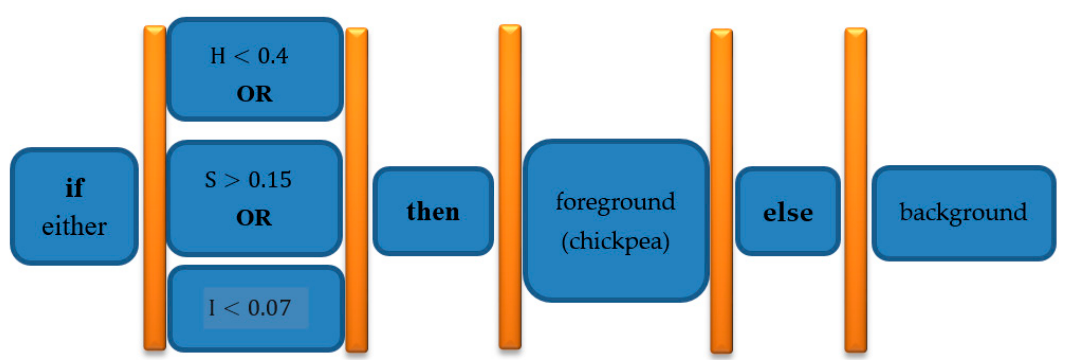
Figure 3. HSI color space segmentation Equation (1) flowchart for clarification purposes: background and foreground (chickpea) pixel segmentation.